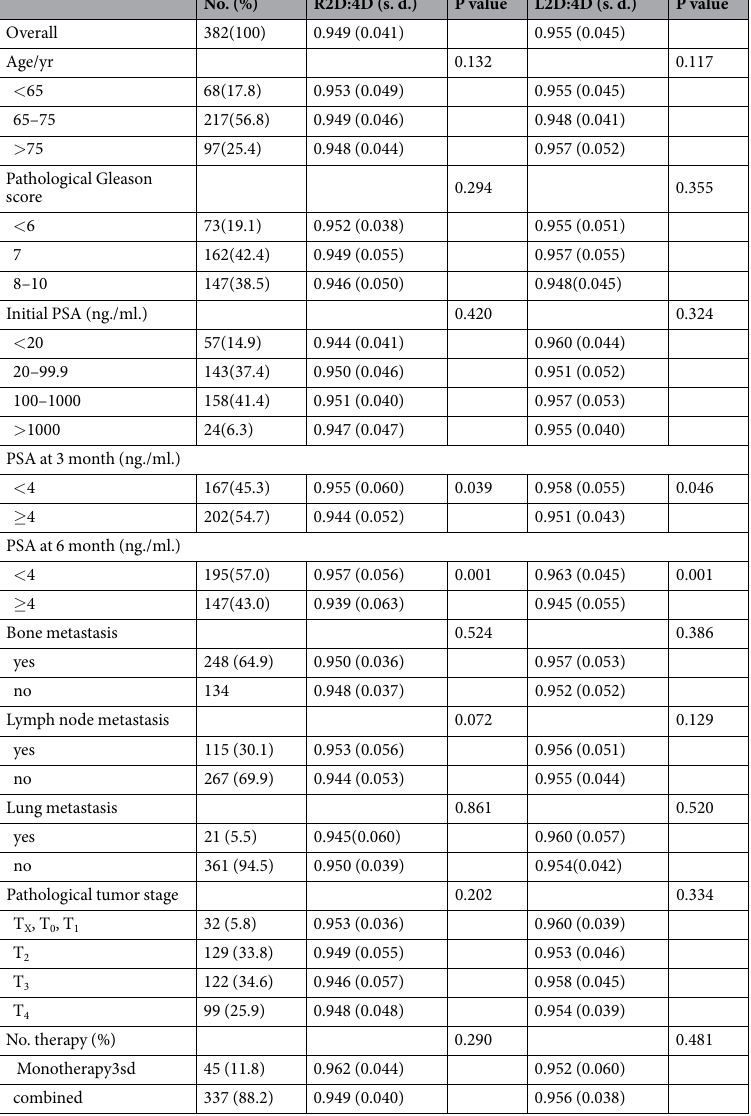
Table 2. Relationship between clinicopathological factors and 2D:4D